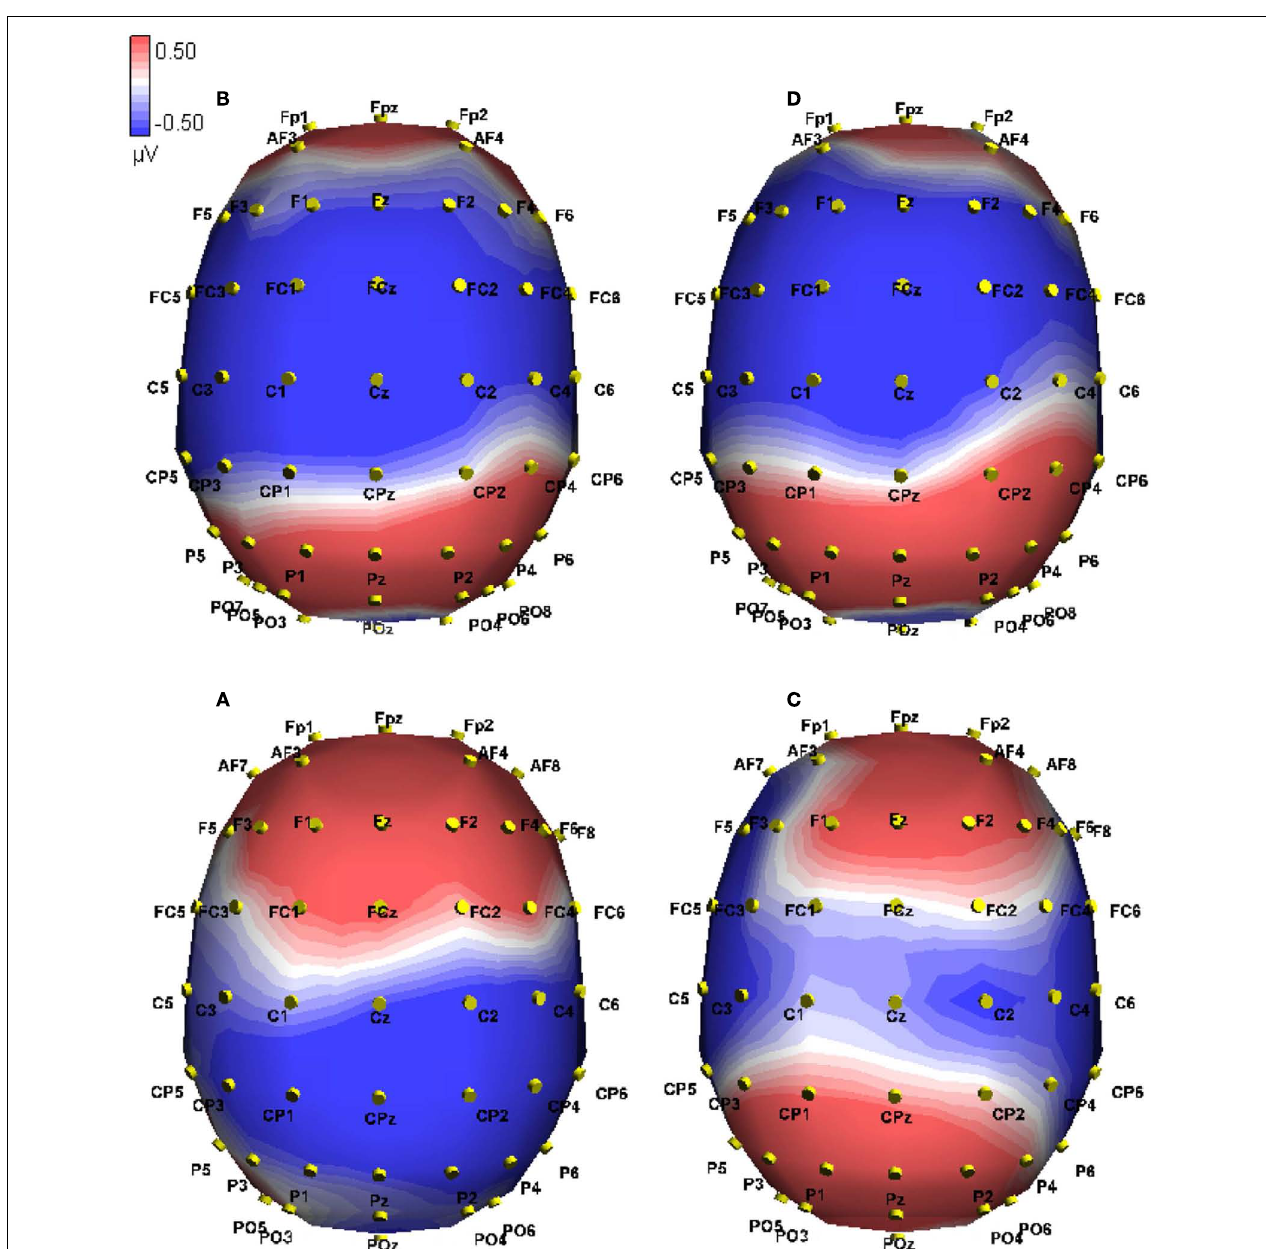
negative potentials, red hues positive potentials.The conditions shown areTrue-Match (B) , False-Match (D) ,True-Mismatch (A) , and False-Mismatch (C)